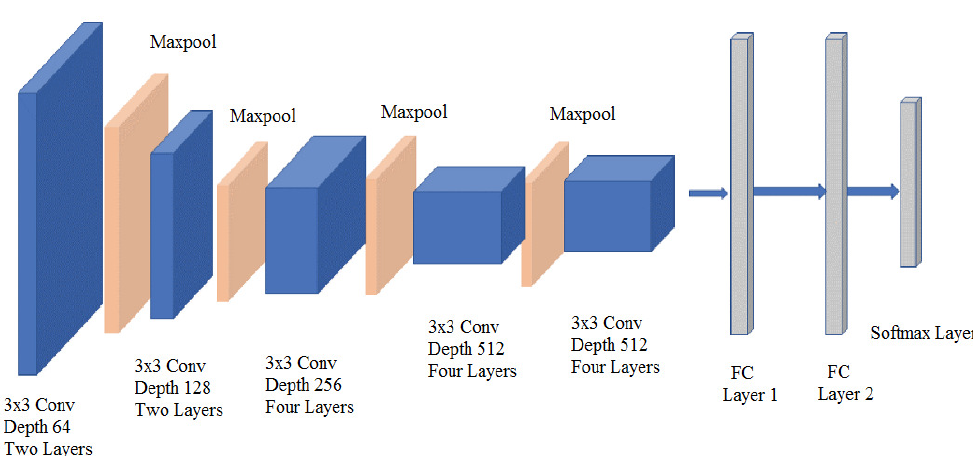
Figure 13. Architecture of the VGG19 Neural Network.